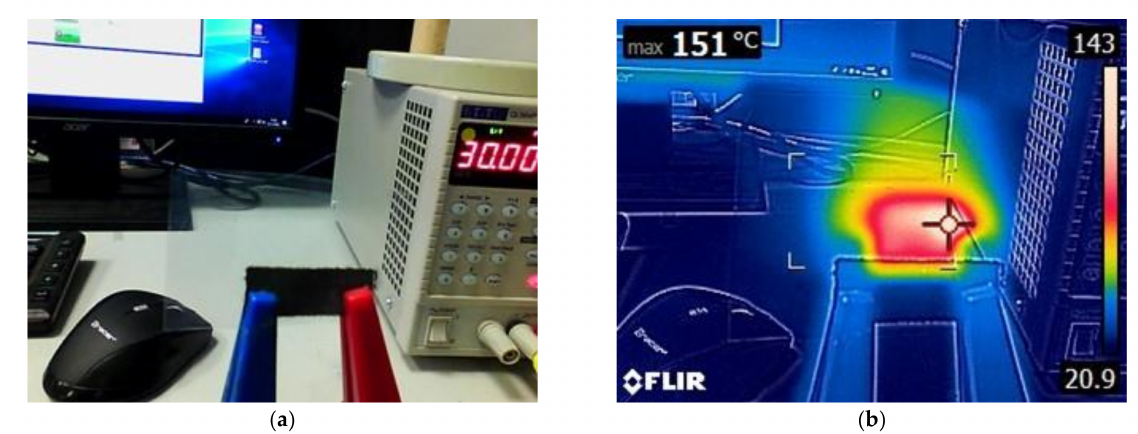
Figure 4. Photos showing measurement of heater screen-printed with 12 wt.% graphene paste taken with a thermal camera: ( a ) regular picture, ( b ) thermal picture.